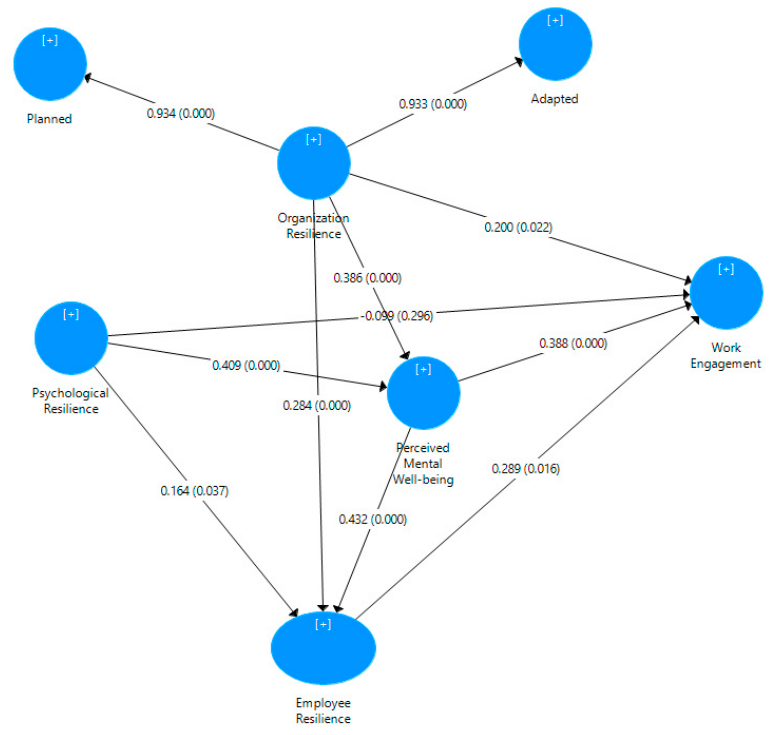
Figure 3. PLS model result.